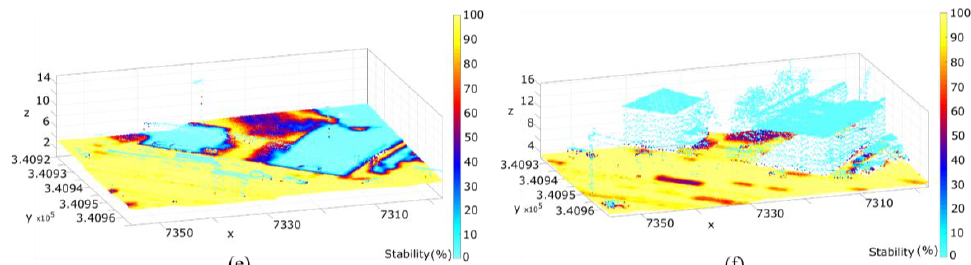
Figure 4. Stability feature for change detection: ( a ) stability shown for 2007 as color value, reaching from 0 (cyan) to 100% (yellow); ( b ) stability shown for 2015; ( c ) point cloud of 2007 shown as height value in an specific area; ( d ) point cloud of 2015 shown as height value in an specific area; ( e ) stability value range in specific area of 2007; and ( f ) stability value range in specific area of 2015.